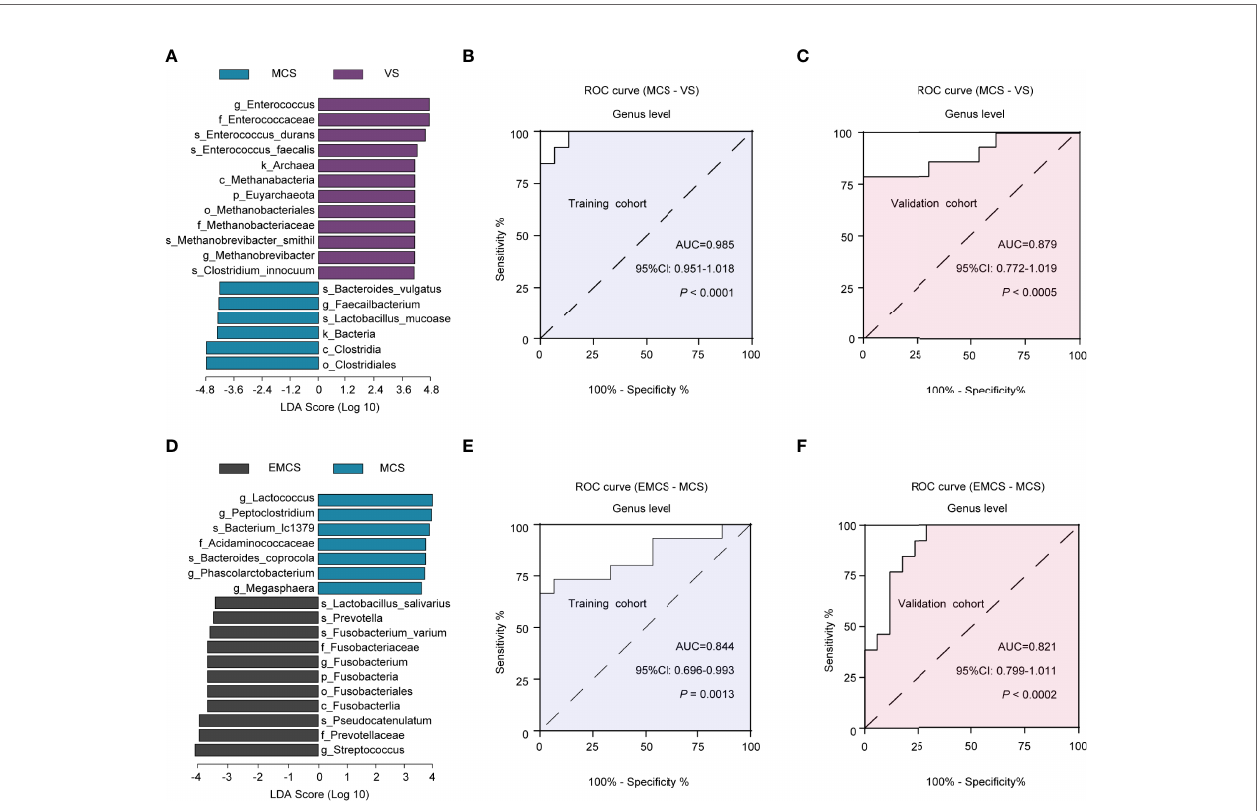
FIGURE 6 | Linear discriminant analysis (LDA) effect size (LEfSe) method used for the altered fecal microbiota and the identi fi cation of candidate biomarkers in the discovery and validation cohorts. (A) The LDA scores showed signi fi cant differences in the microbiota composition between the MCS and VS groups. Only those taxa with an LDA threshold >4 are shown. (B, C) ROC curves for Enterococcus , Methanobrevibacter , and Faecalibacterium used in distinguishing between MCS and VS patients in the discovery cohort (B) and in the validation cohort (C) . (D) The LDA scores showed signi fi cant differences in the microbiota composition between the EMCS and MCS groups. Only those taxa with an LDA threshold >3.5 are shown. (E, F) ROC curves for Lactococcus and Streptococcus used in distinguishing EMCS from MCS patients in the discovery cohort (E) and in the validation cohort (F) . ROC , receiver operating characteristic; AUC , area under the ROC curve; EMCS , emerged from minimally conscious state; MCS , minimally conscious state; VS , vegetative values of 0.895 (cutoff = 0.017, p = 0.0011, 95%CI = 0.758 – 1.033) between the MCS-Abx and VS-Abx groups ( Supplementary Figure S3C ) and 0.647 (cutoff = 0.821, p = 0.2235, 95%CI = 0.420 – 0.875) between the EMCS-Abx and MCS-Abx groups ( Supplementary Figure S3D ).